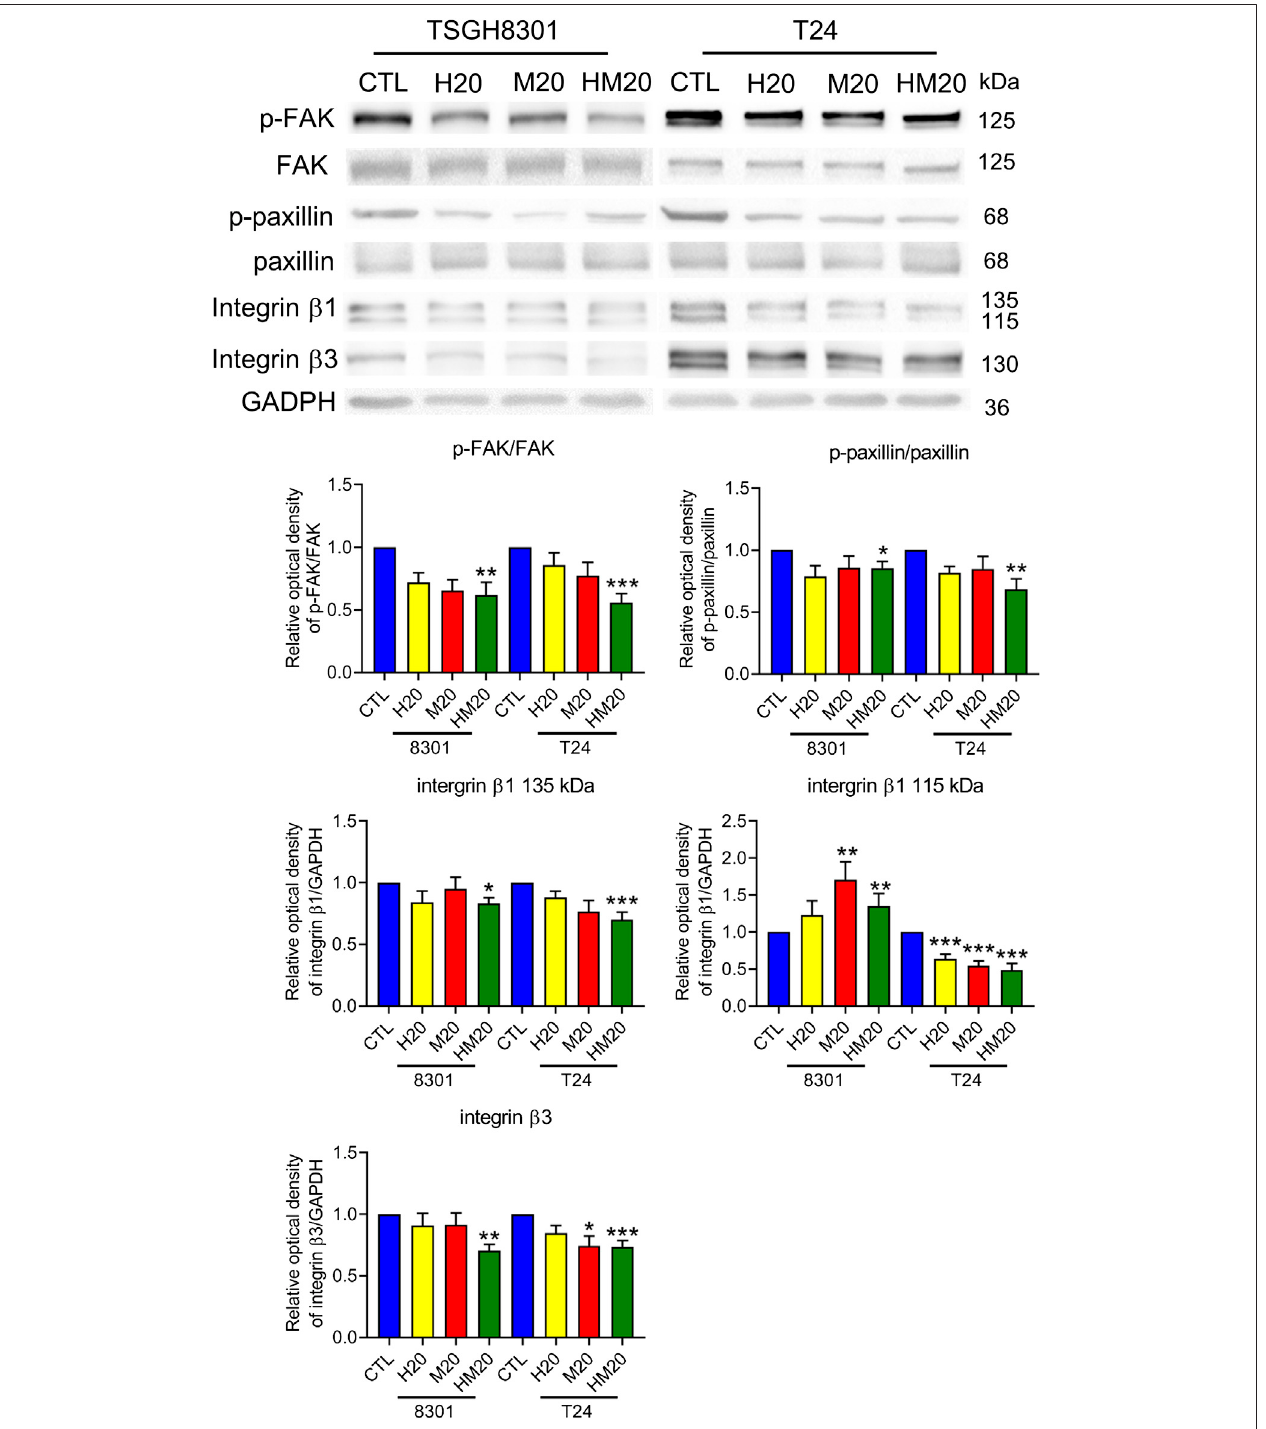
FIGURE5| Hono-Magreducedtheactivityofthefocaladhesioncomplex.BladdercancercellsweretreatedwithHono,Mag,orHono/Mag(20 μ M)for24 h.Then, cell lysates were analyzed for integrin β 1, FAK, p-FAK, paxillin, and p-paxillin by Western blotting. The results are representative of those obtained in fi ve experiments. GAPDH was used as the loading control. Lower panels, quantitative analyses of the levels of the aforementioned proteins; * p < 0.05 compared to the control group.